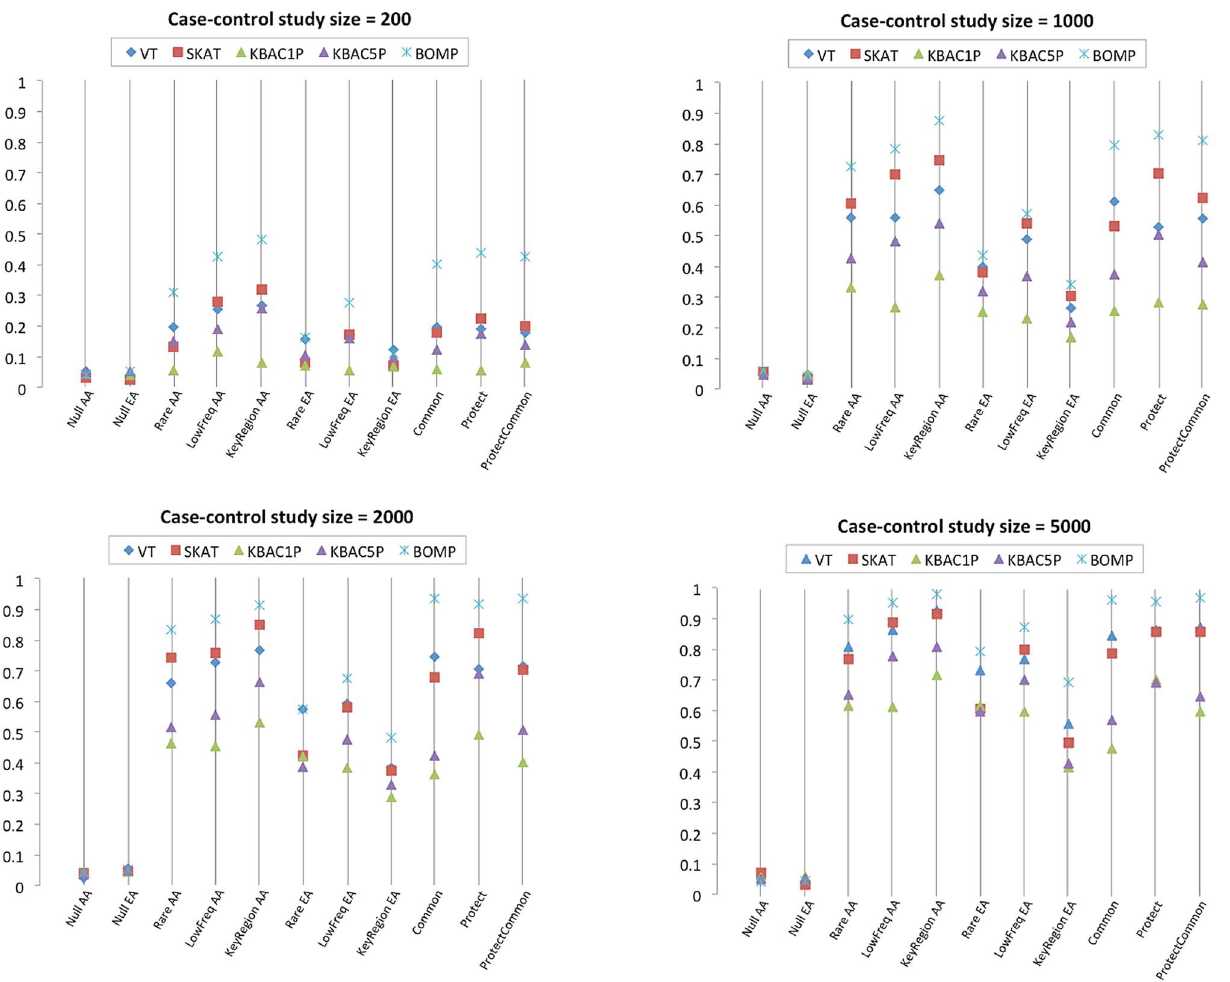
Figure 3. Power estimates for multiple genes case-control studies with causal variants from disease etiologies randomly sampled from nine multinomial distributions (Figure S3). Power estimates for BOMP, VT, SKAT, KBAC (KBAC1P=minor allele frequency defined as v 1% , KBAC5P=minor allele frequency defined as v 5% ). Each vertical line represents power estimates for each method, based on 250 simulated case- control studies. The genomic individuals each had nine genes, of which three contained causal variants and six did not. The disease etiologies for the three genes with causal variants were randomly sampled from nine multinomial distributions (Figure S3). AA=African-American simple bottleneck demographic model. EA=European-American exponential growth demographic model.